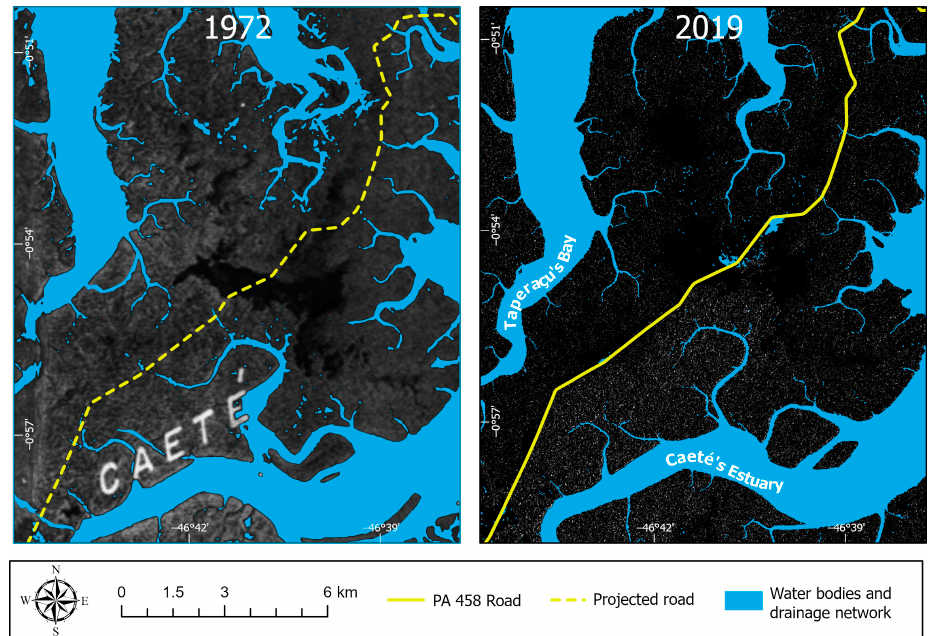
Figure 14. Radar imagery showing the drainage network before (1972, X-band, Side-Looking Air- borne Radar) and after (2019, Sentinel-1 C-band Synthetic Aperture Radar) the construction of Highway PA-458.